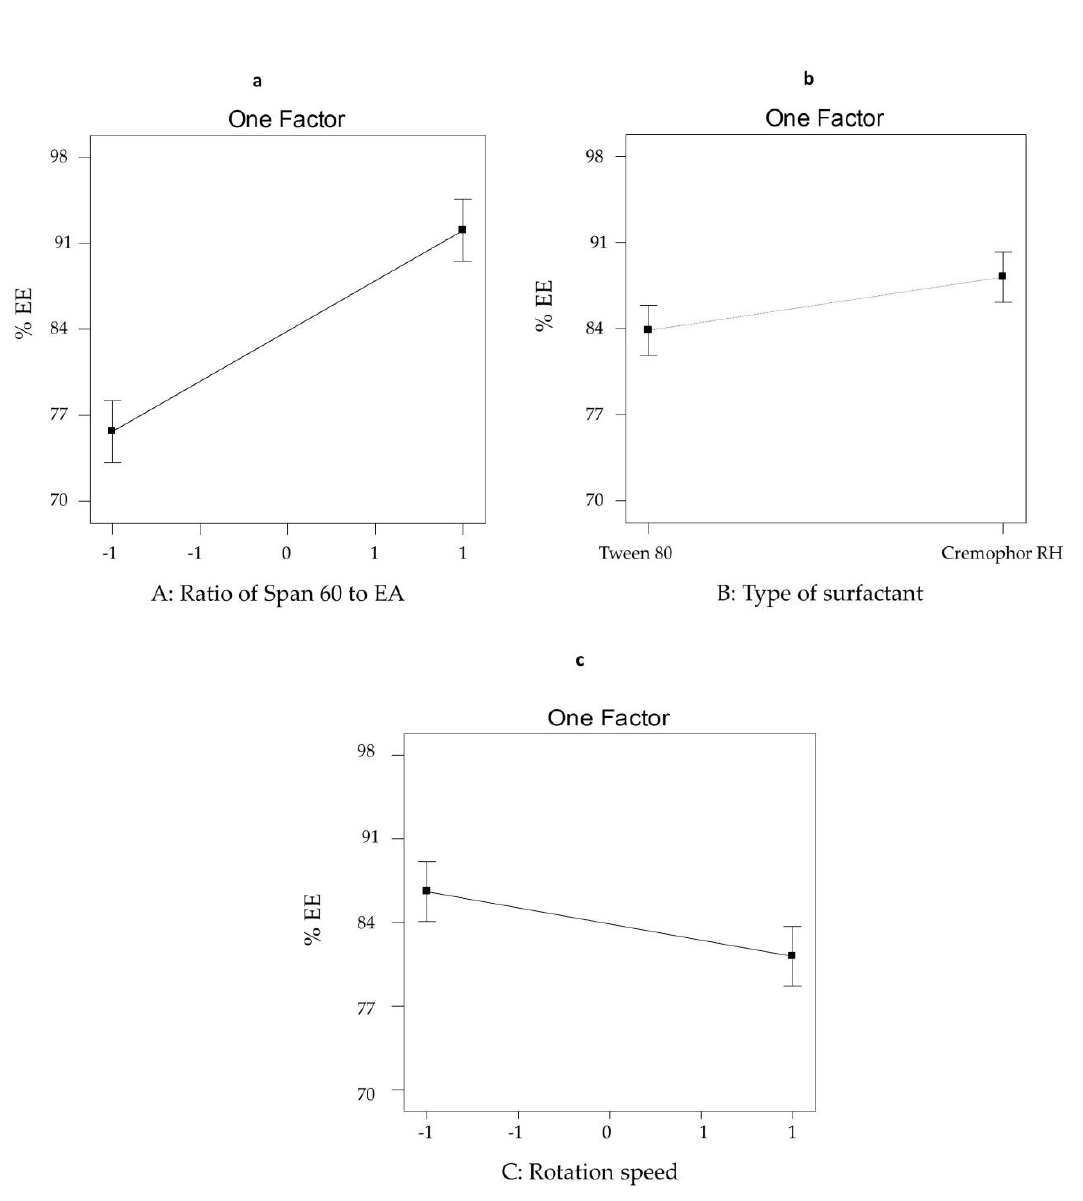
Figure 1. The influence of different independent variables ( a ) ratio of Span 60 to EA, ( b ) type of surfactant and ( c ) rotation speed on %EE of SV-loaded nanospanlastics according to 2 3 factorial design. Abbreviations: SV, Sodium valproate; EE, entrapment efficiency.